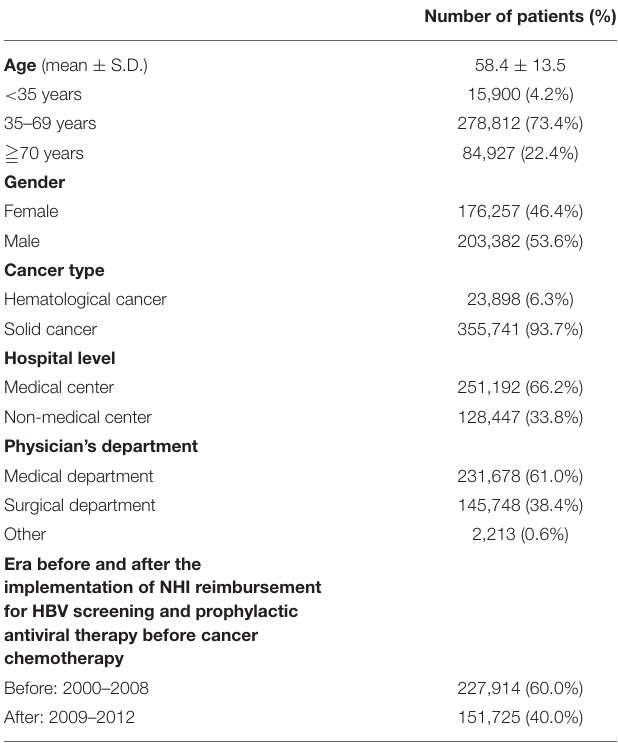
TABLE 1 | Demographic data of all patients (Total N = 379,639).